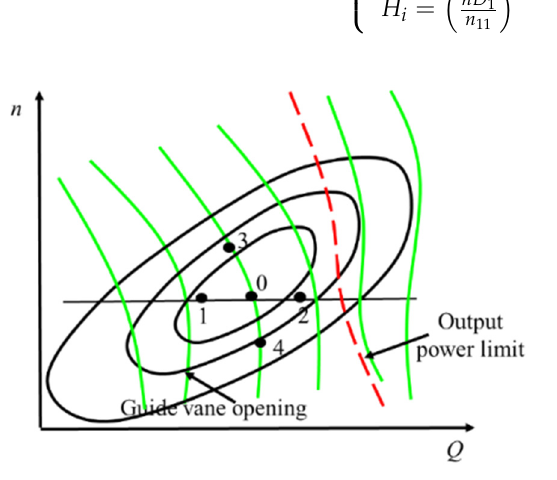
Figure 3. The synthetic characteristic curve of a pump turbine.